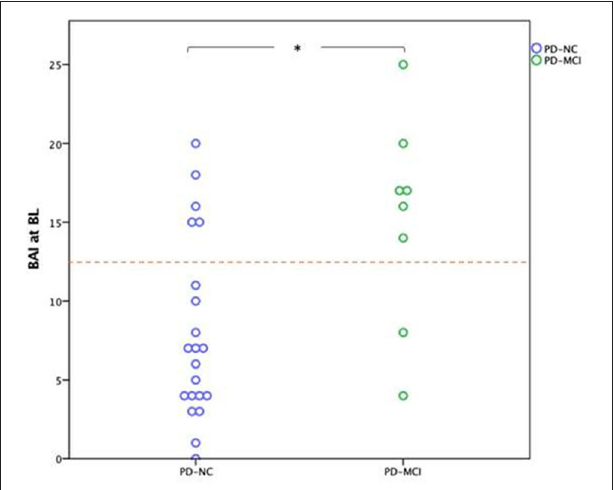
FIGURE 1 | Dots represent the Baseline BAI scores of patients regarding their cognitive status at three years follow-up. The boxes include the median and the values between the 25th and 75th percentiles; * p < 0.01; The cutoff is 13. PD-NC, Parkinson’s disease patients with normal cognitive; PD-MCI, Parkinson’s disease patients with mild cognitive impairment; BAI, Beck Anxiety Inventory; BL, Baseline. AI scores of patients regarding their cognitive status at three years